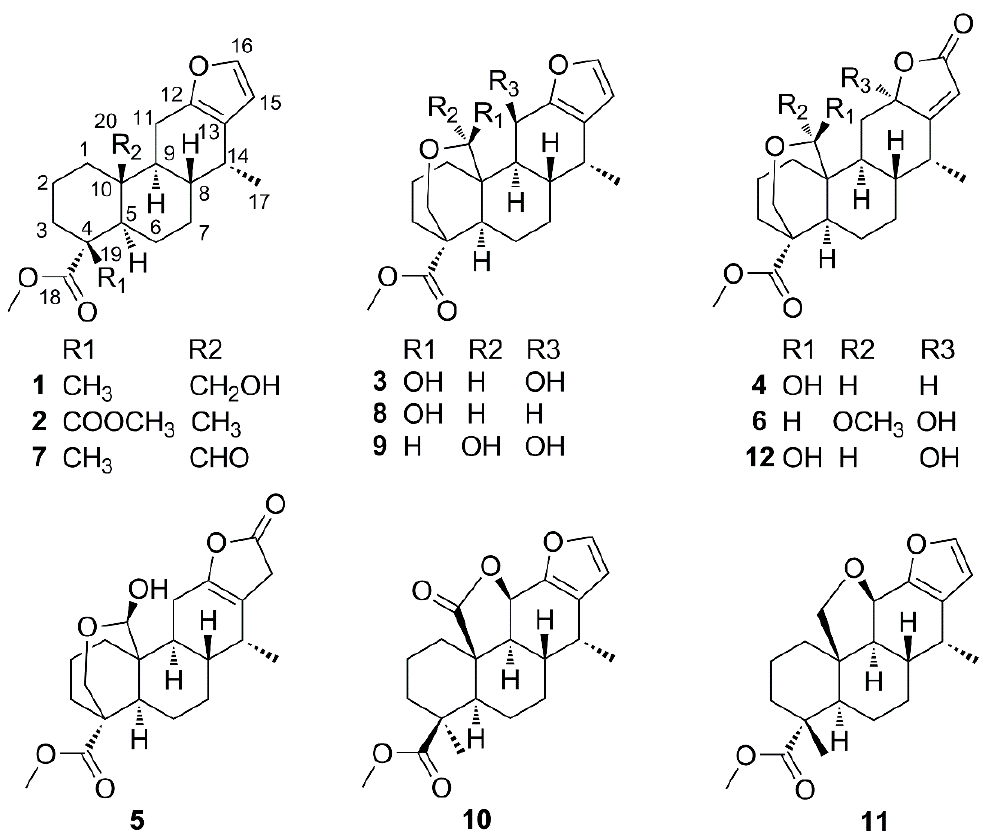
Figure 1. Chemical structures of compounds 1 – 12 .